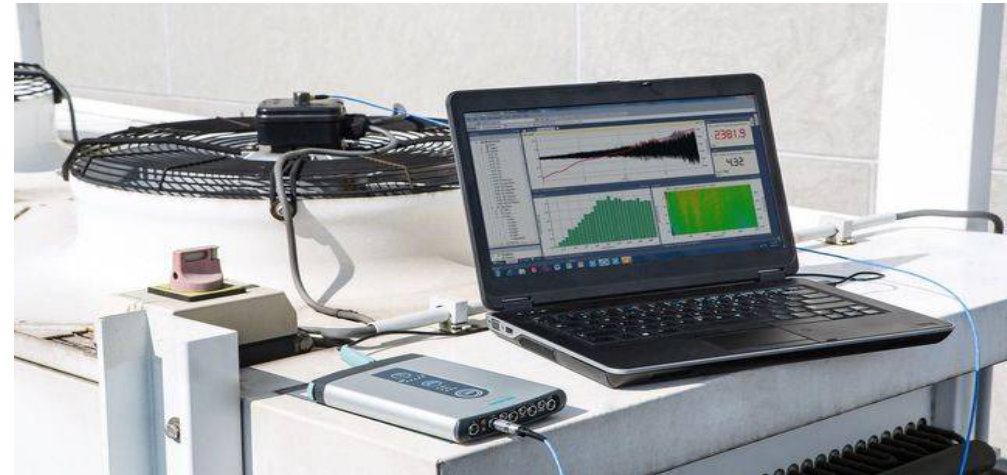
Figure 2. SIEMENS LMS Test.Xpress measuring equipment.